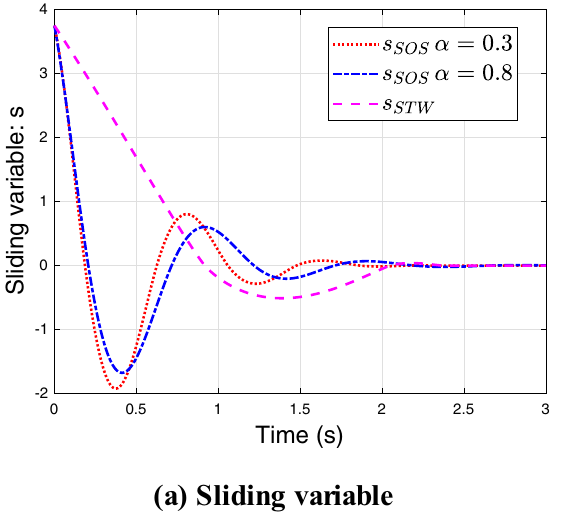
Fig. 2 Comparison of oscillation angle and velocity of oscillation angle for SOSMC and STW